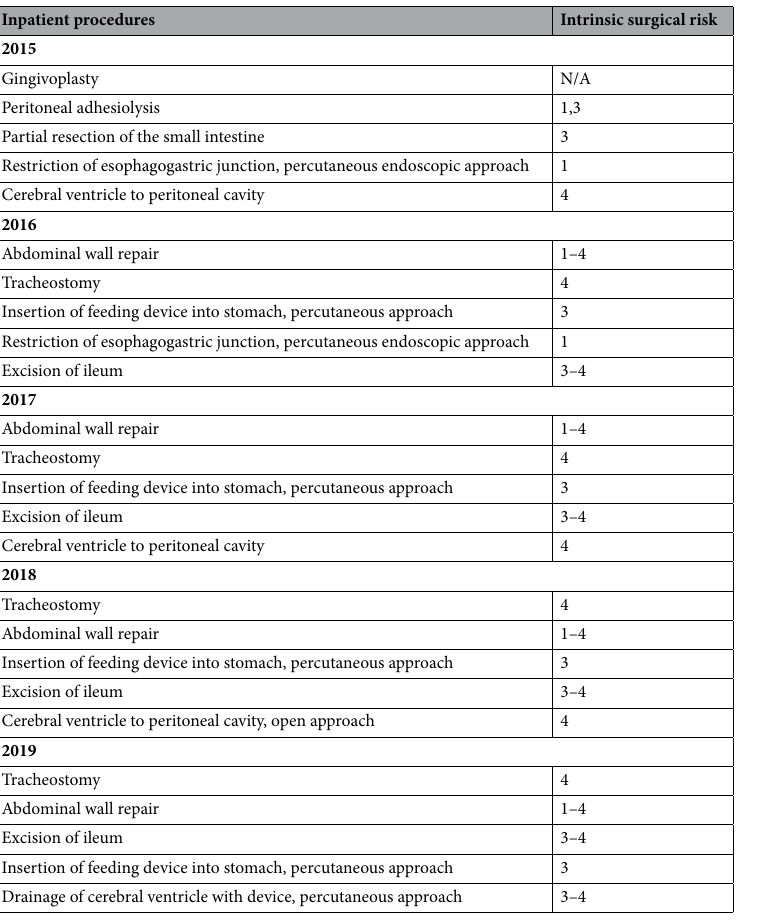
Table 6. Most common inpatient noncardiac